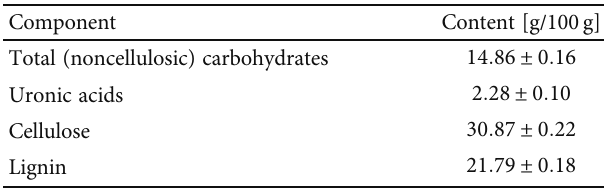
Figure 1: Preparation of deproteinized ethanol-treated sun fl ower meal. Table 1: Biochemical composition of deproteinized ethanol-treated Table 2: Fractional pro fi le of alcohol-insoluble deproteinized sun fl ower meal. ethanol-treated sun fl ower